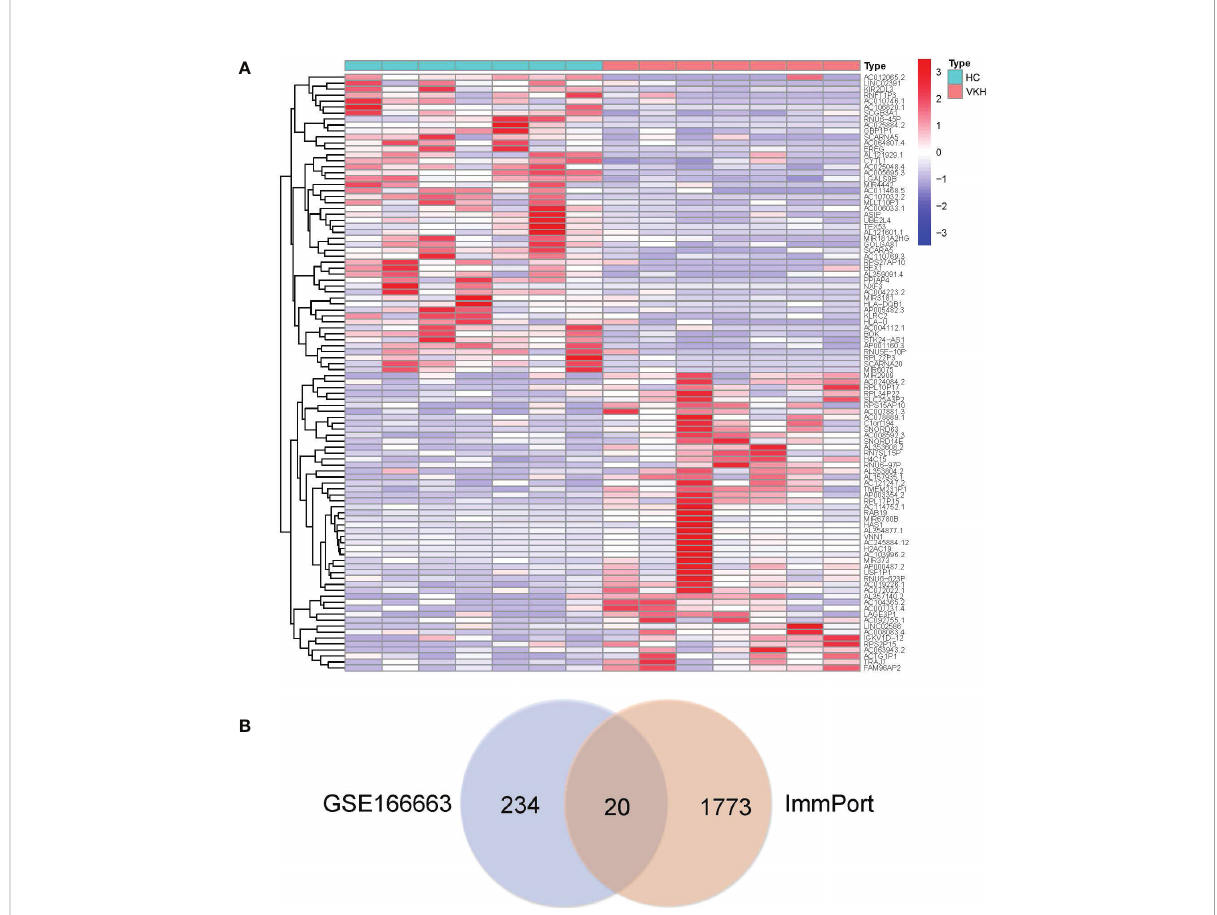
FIGURE 1 In total, 254 differentially expressed genes (DEGs) were identi fi ed in Vogt-Koyanagi-Harada (VKH) patients and healthy controls (HC) and the top 50 DEGs are shown in (A) the heatmap, with signi fi cantly up-regulated genes marked in red and signi fi cantly down-regulated genes marked in blue. (B) Venn diagram of immune DEGs. Clinical dataset of VKH disease (GSE166663) and immune dataset (ImmPort) were intersected to identify immune